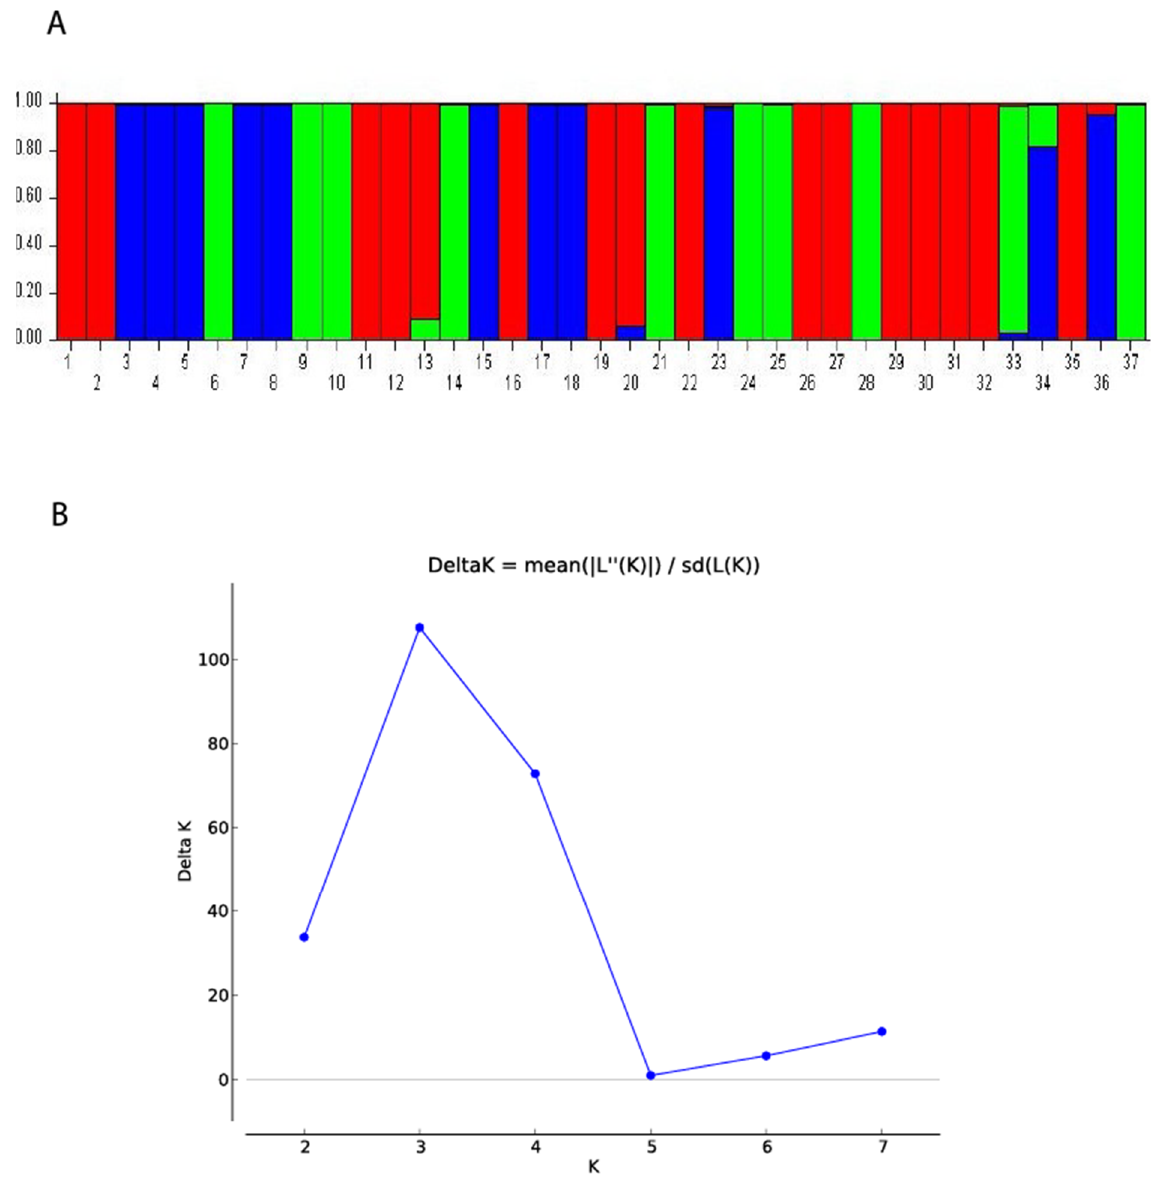
Figure 4. Structure analyses summary. ( A) Bar plots showing the relationships for all 37 Saprolegnia strains in the study assessed on the basis of AFLP data; each strain is represented by a vertical line. The Saprolegnia isolates are sorted according to their ID number (Table 1). ( B ) The values for seven independent runs for K = 1–7 and DeltaK = mean (L’’(K)I)/s(L(K)).